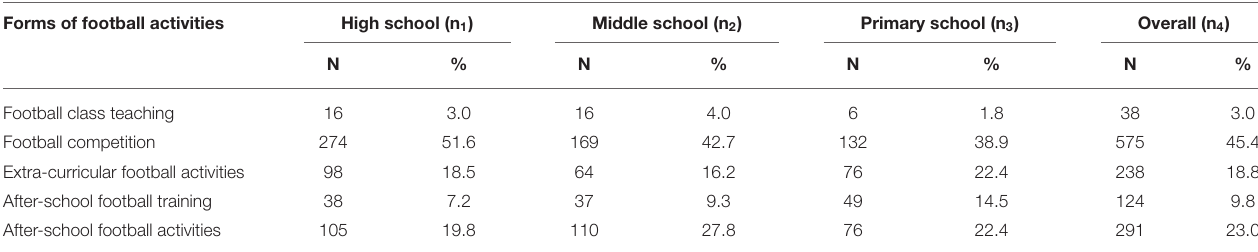
TABLE 3 | Football activities that result in campus football injuries.